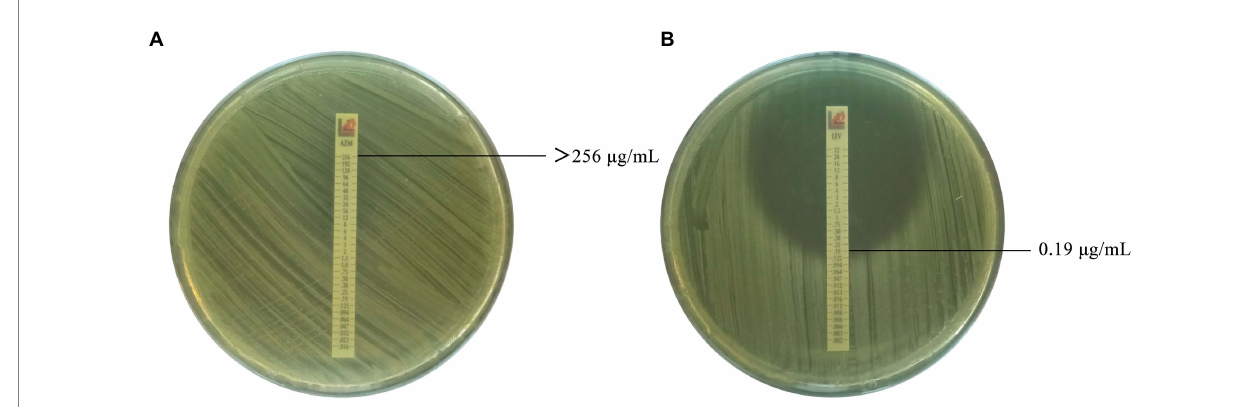
FIGURE 1 Antimicrobial susceptibility of Brucella isolates to cephalosporins (partial). (A) Azithromycin against Brucella isolate 637 with MIC value of >256 μ g/mL. (B) Levofloxacin against Brucella isolate 637 with MIC value of 0.19 μ g/mL.